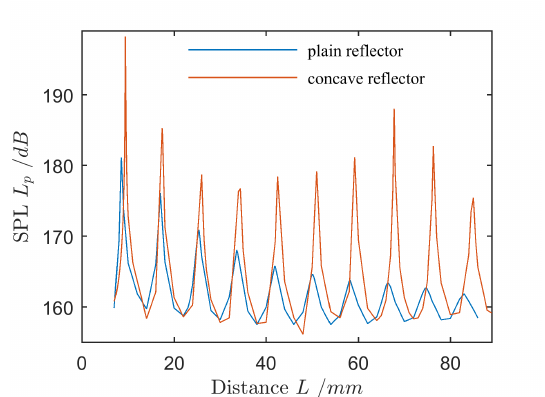
Figure 6. Sound pressure level (SPL) from FE-Model over distance L for concave ( R = 72 mm) and plain reflector; f = 21.4 kHz; ˆ x = 19 µ m.